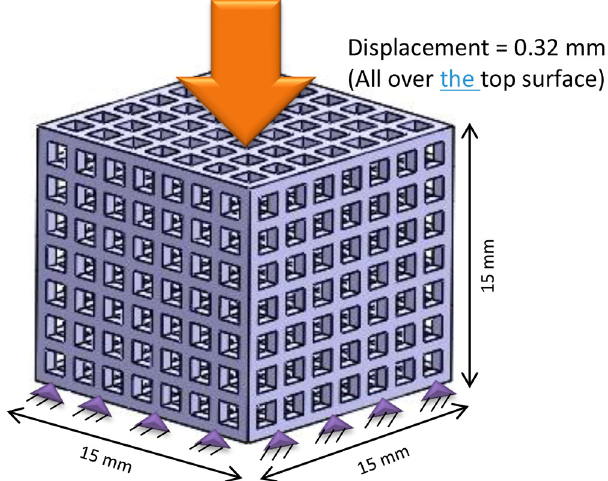
Fig. 4. Loading and boundary conditions applied on the Cubic (76) porous structure (similar loading and boundary conditions were applied to the BCC and Spherical porous structure models).